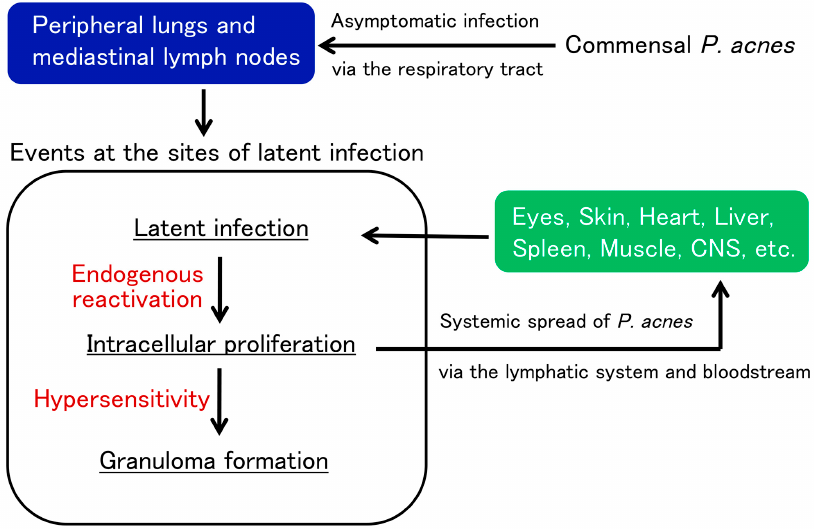
Figure 6. Potential pathogenesis of sarcoidosis as an allergic endogenous infection caused by P. acnes . Commensal P. acnes causes asymptomatic intracellular infection and persists in the peripheral lungs and mediastinal lymph nodes. Latent P. acnes is activated endogenously under certain conditions and proliferates intracellularly at the sites of latent infection. In patients with Th1 hypersensitivity to P. acnes , granulomatous inflammation is triggered by intracellular proliferation of the bacterium. Extracellular P. acnes that escaped granulomatous confinement or local phagocytosis potentially cause new latent infection in multiple organs via the lymphatic system and bloodstream dissemination. The latent infection spread in systemic organs can be simultaneously reactivated by additional triggering events, leading to granuloma formation at all sites of latent